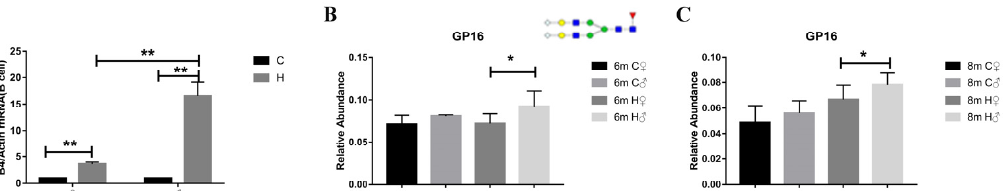
Figure 6. Female mice have a lower cancer incidence and do not show obvious increase in B-cell B4GALT1 gene expression in contrast to male mice, who have a higher cancer incidence, and the relative abundance of GP16 is significantly lower in female mice than it is in male mice. ( A ) Approx- imately 1 month after administration, the B4GALT1 mRNA level in spleen B cells increased more significantly in males than in females. ( B ) The relative abundance of GP16 in males at 6 months after administration was significantly higher than that in females. ( C ) The relative abundance of GP16 in males at 8 months after administration was significantly higher than that in females.* p <